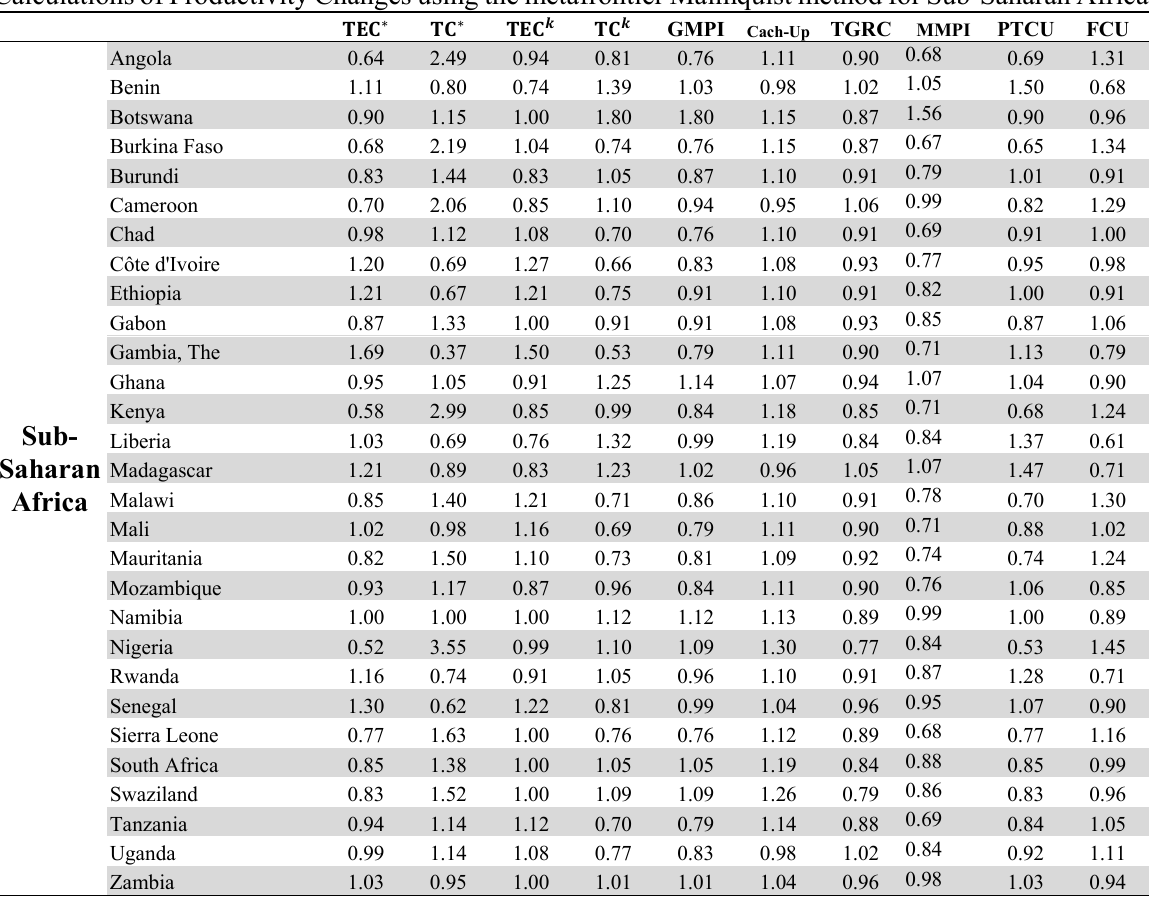
Calculations of Productivity Changes using the metafrontier Malmquist method for Sub-Saharan